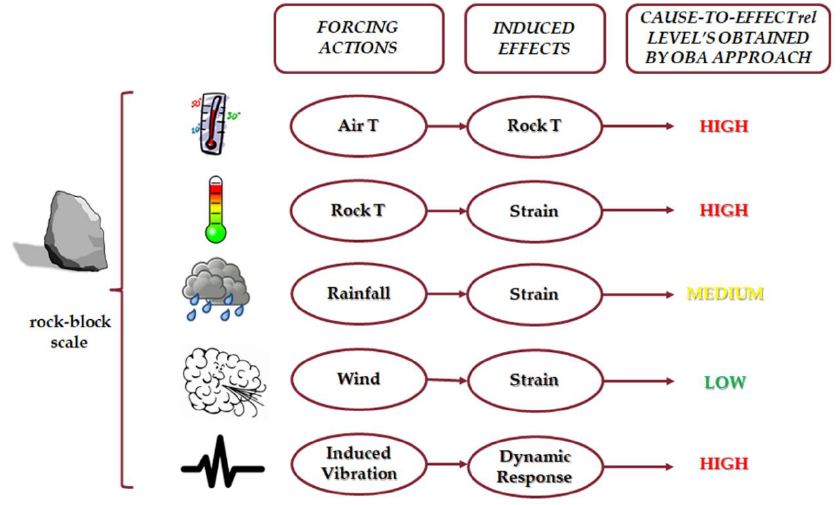
Figure 12. Results from the OBA experienced at the Acuto test-site with the associated severity levels from objective cause-to-e ff ect